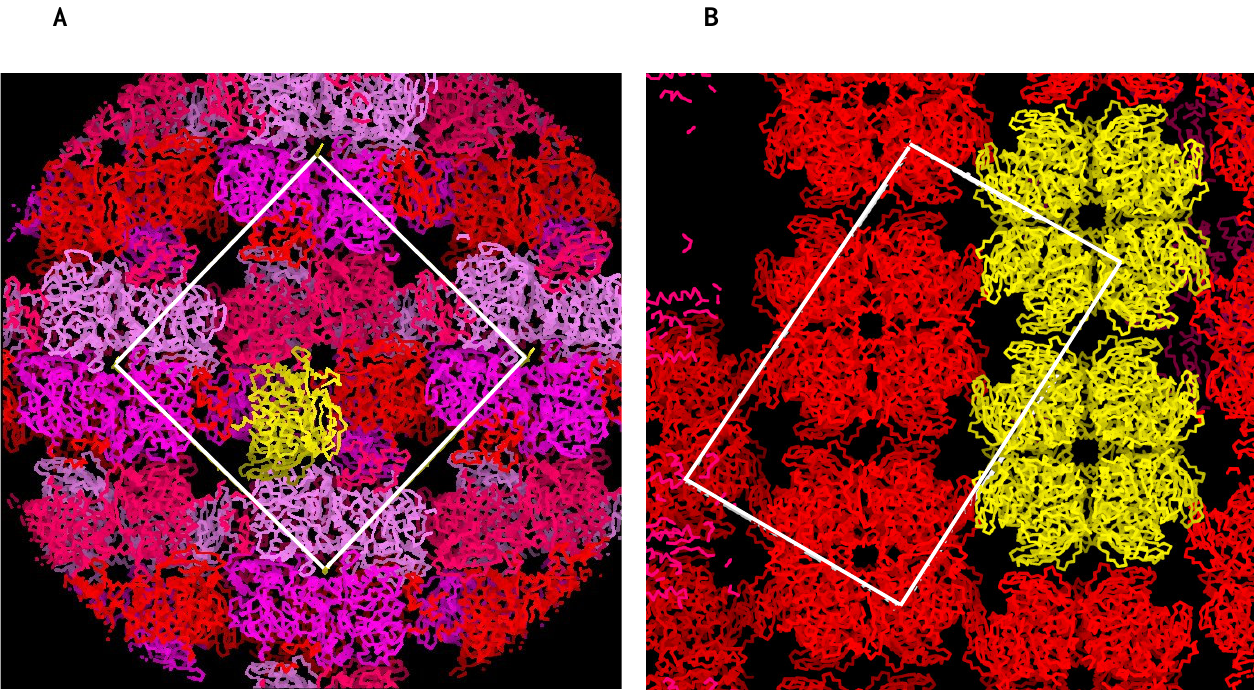
Figure 4. Packing diagrams for both crystal forms of RUBISCO: (A) I422 crystal form (large and small subunit in yellow) (B) P2 crystal form 2a, (C) P2 crystal form 2b. 1 1 Please note similarities in packing, despite the difference in the cell dimensions and contents of the asymmetric unit (hexadecamers in yellow). (D) Comparison of both crystal lattices represented by superposition of the two independent hexadecamers of the form 2a (in purple) onto the single hexadecamer of form 2b (yellow). The effective rotation of the second hexadecamer by ~3° results in aligning them and the reduction of the asymmetric unit.